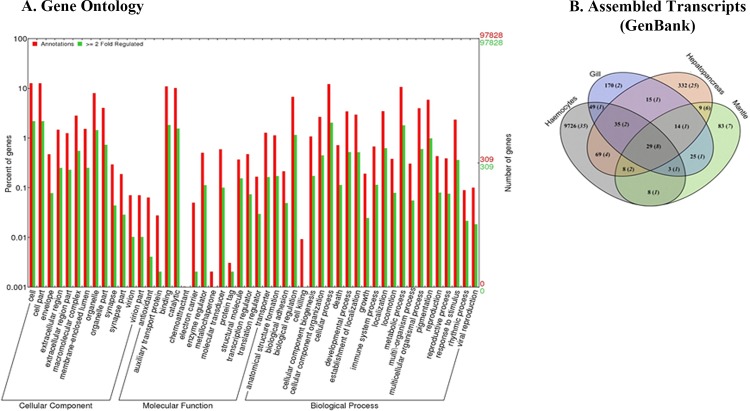
GO categories and 2 fold expressed transcripts.(A) Histogram presentation of GO classification showed transcripts in numbers after annotated in three categories: cellular components, molecular functions, biological processes. (B) Venn diagram shows 2-fold expression of transcripts in H. discus hannai transcriptome in tissue specific manner. The numbers shown in brackets represent the nucleotide sequences available in GenBank.